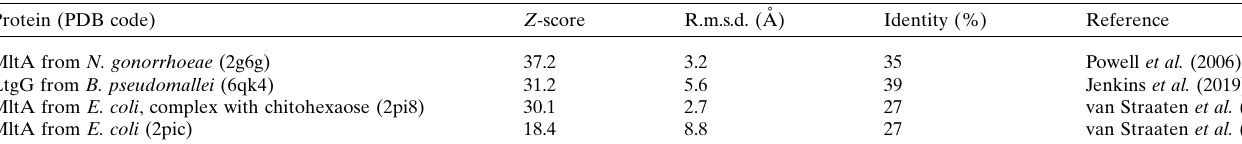
Table 2 Structural similarity search using DALI (Holm & Sander,